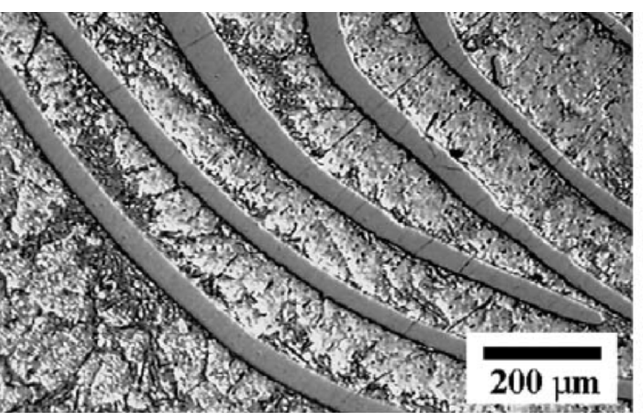
Figure 3. Microstructure of Ni ‐ Nb ‐ Ta metallic glass ribbon ‐ reinforced Al ‐ Si ‐ Mg alloy matrix composite. Reprinted from [35], Copyright (2004), with permission from Elsevier.